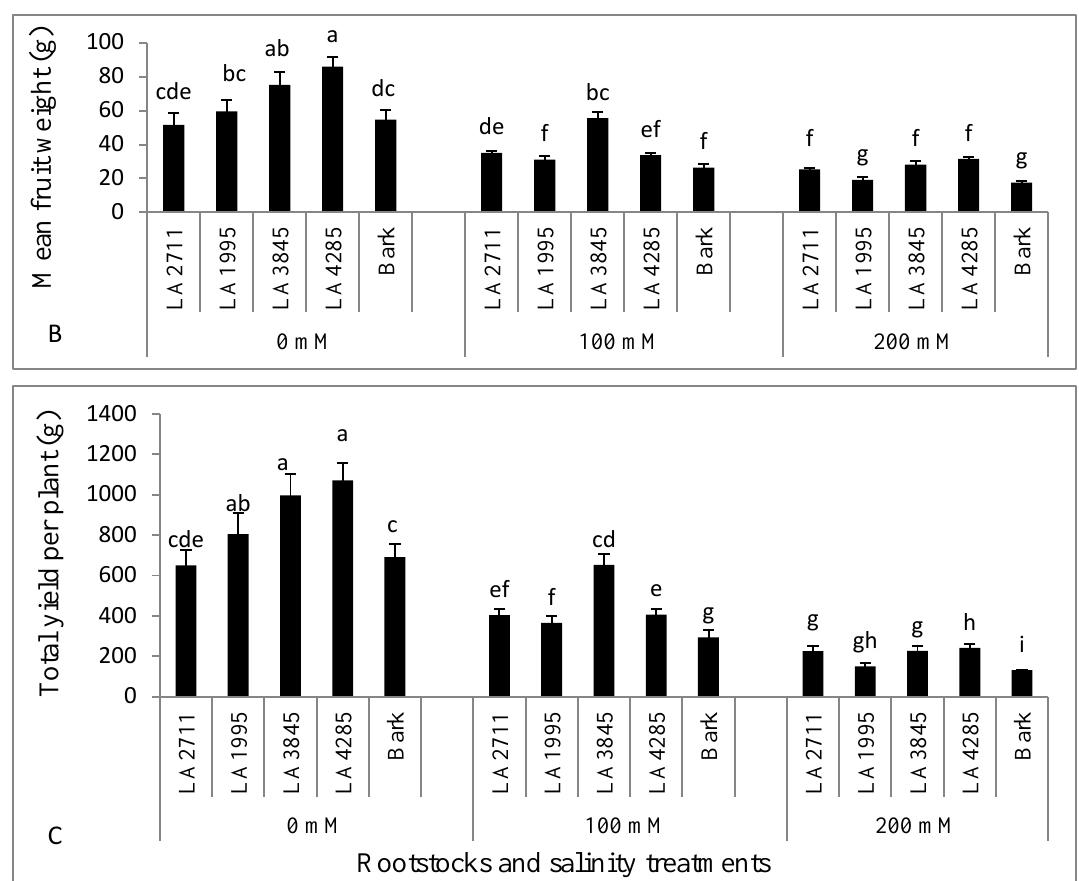
Figure 4: Effect of salinity levels × rootstocks interaction on ( A ) number of fruits, ( B ) mean fruit weight (g), and ( C ) total yield per plant (g). Vertical bars represent standard errors of means ( n = 3); in each bar, values followed by different letters differ significantly at p = 0.05 according to Tukey test.